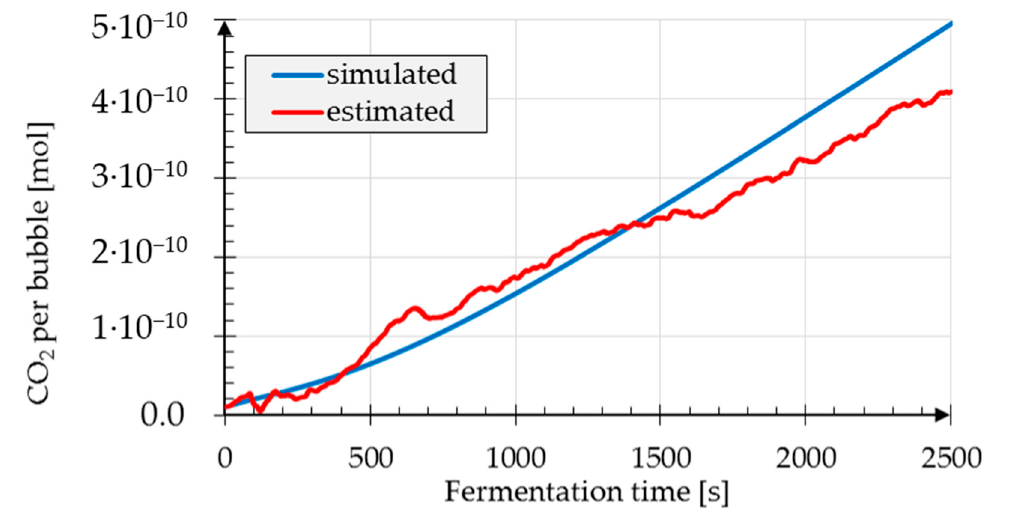
Figure 2. Simulated and Kalman estimation of the amount of CO 2 in a bubble.